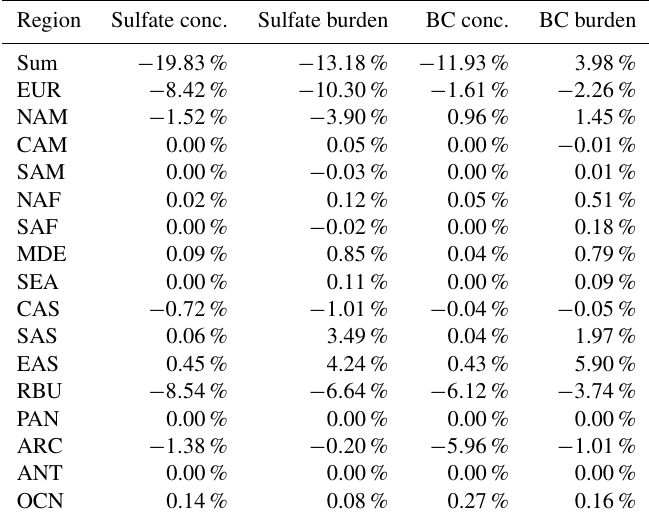
Table 2. Trends in annual mean sulfate and BC concentrations (% per decade) in surface air and in column contributed by 16 anthropogenic source regions during 1980–2018 relative to the 39-year averages of total concentrations. The boldface values are statistically significant at the 95% confidence level based on the F